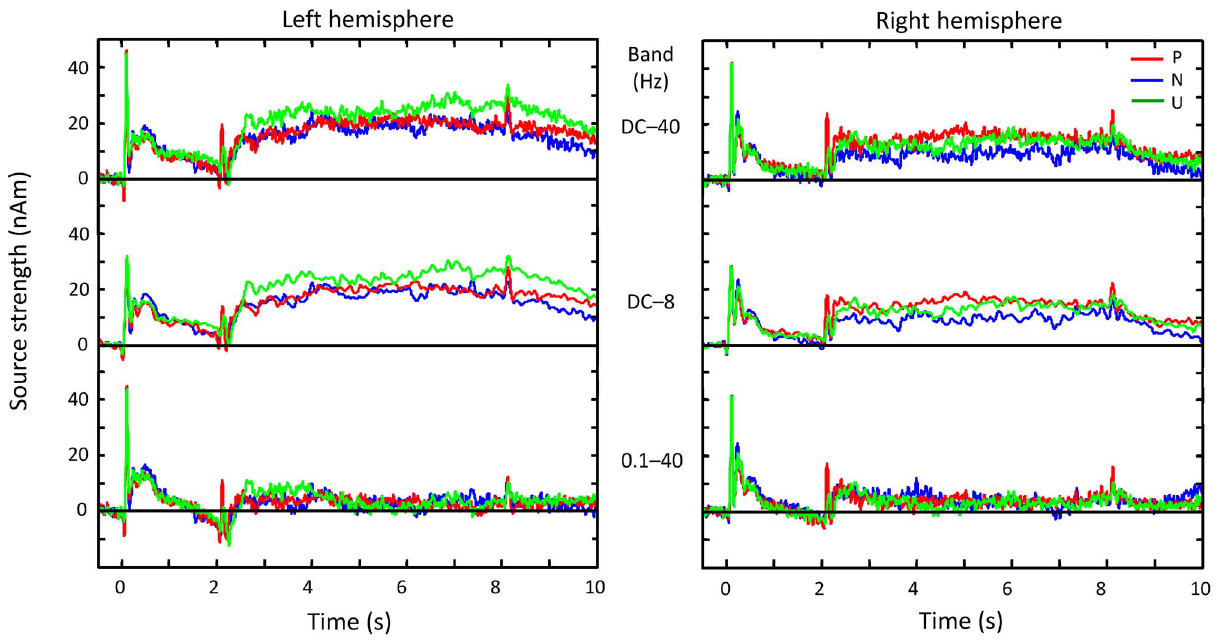
Figure 4. Time courses of grand-average source strengths across 15 subjects. Source strengths (i.e., dipole moments) are shown for full- band (0–40 Hz; upper row), low-pass-filtered (at 8 Hz; middle row) and high-pass-filtered (0.1–40 Hz; lower row) responses as a function of time from 2 0.5 to 10 s. The dipoles were assumed to have the same position and direction as sources of N100m. Baselines were set as the mean level between 2 0.5 and 0 s.